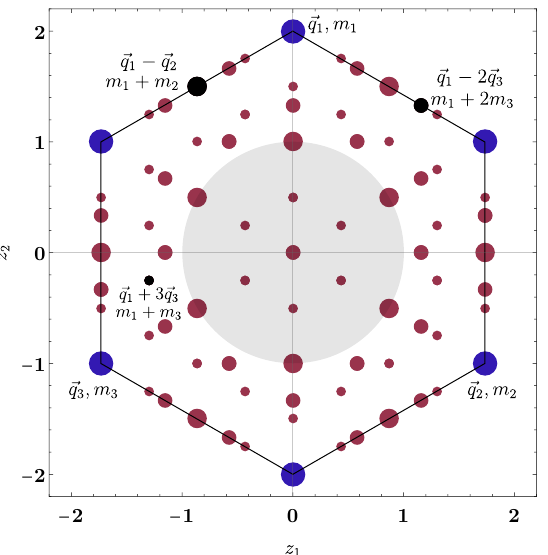
Figure 3 . Multi-particle states of a U(1) 2 with three fundamental particles and their corresponding antiparticles in the spectra. These six particles are displayed with blue dots. The maroon dots are multi-particle states formed from them. The more particles a state has, the smaller the size of the dot representing it. For illustrative purposes we have written the charge and the mass of three randomly chosen states, which appear in black in the figure. We use lower-case letters ~z and ~q to refer to the charges of the single-particle states. The black-hole region is represented by a grey circle. We have chosen m 1 = m 2 = m 3 = 1 and ~q 1 = (0 , 2) , ~q 2 = ( Therefore, the convex hull encloses the black-hole region in our